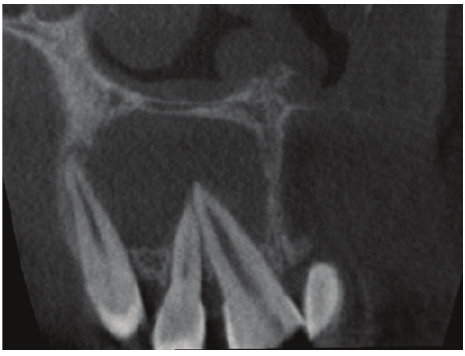
Figure 29: Pre-operative CBCT image in coronal plane.